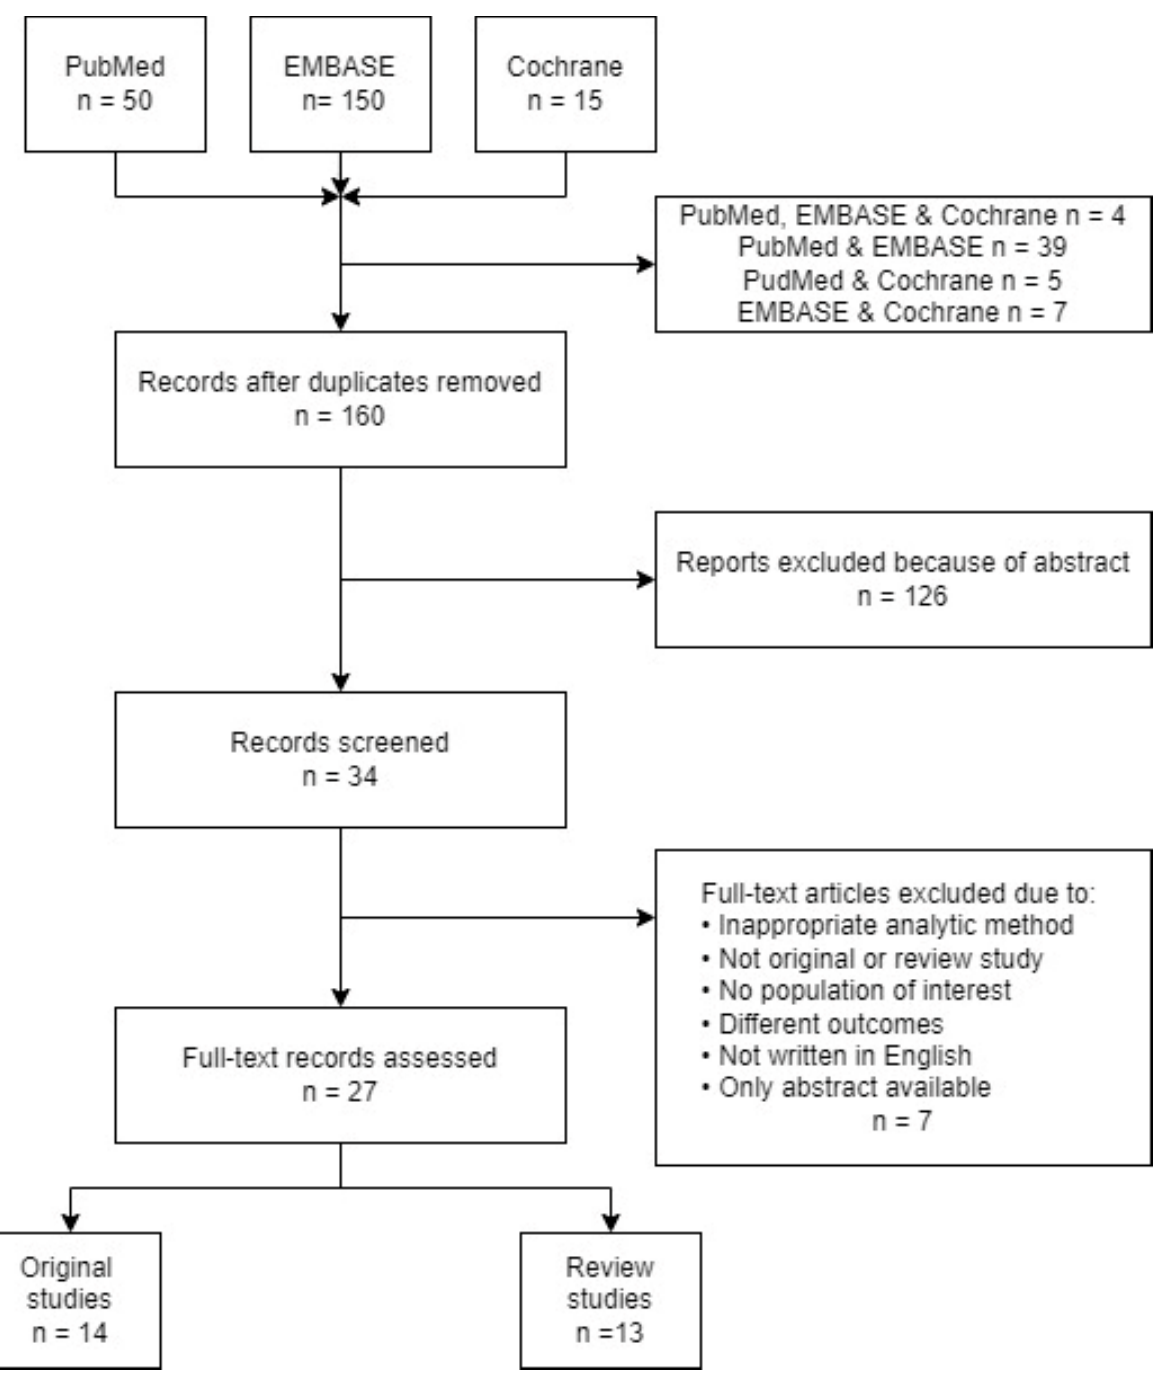
Figure 1. Search strategy: PRISMA flowchart.